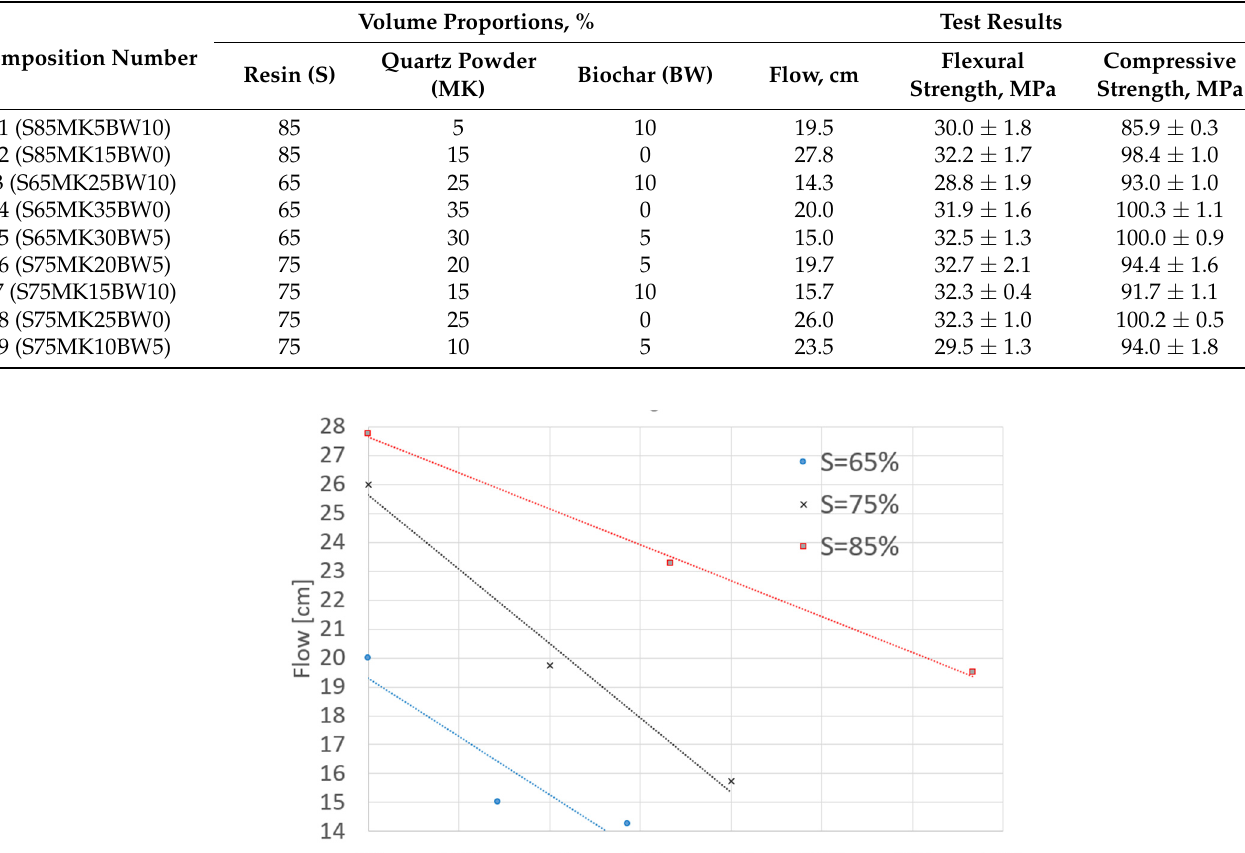
Table 4. The result of consistency, flexural and compressive strength.